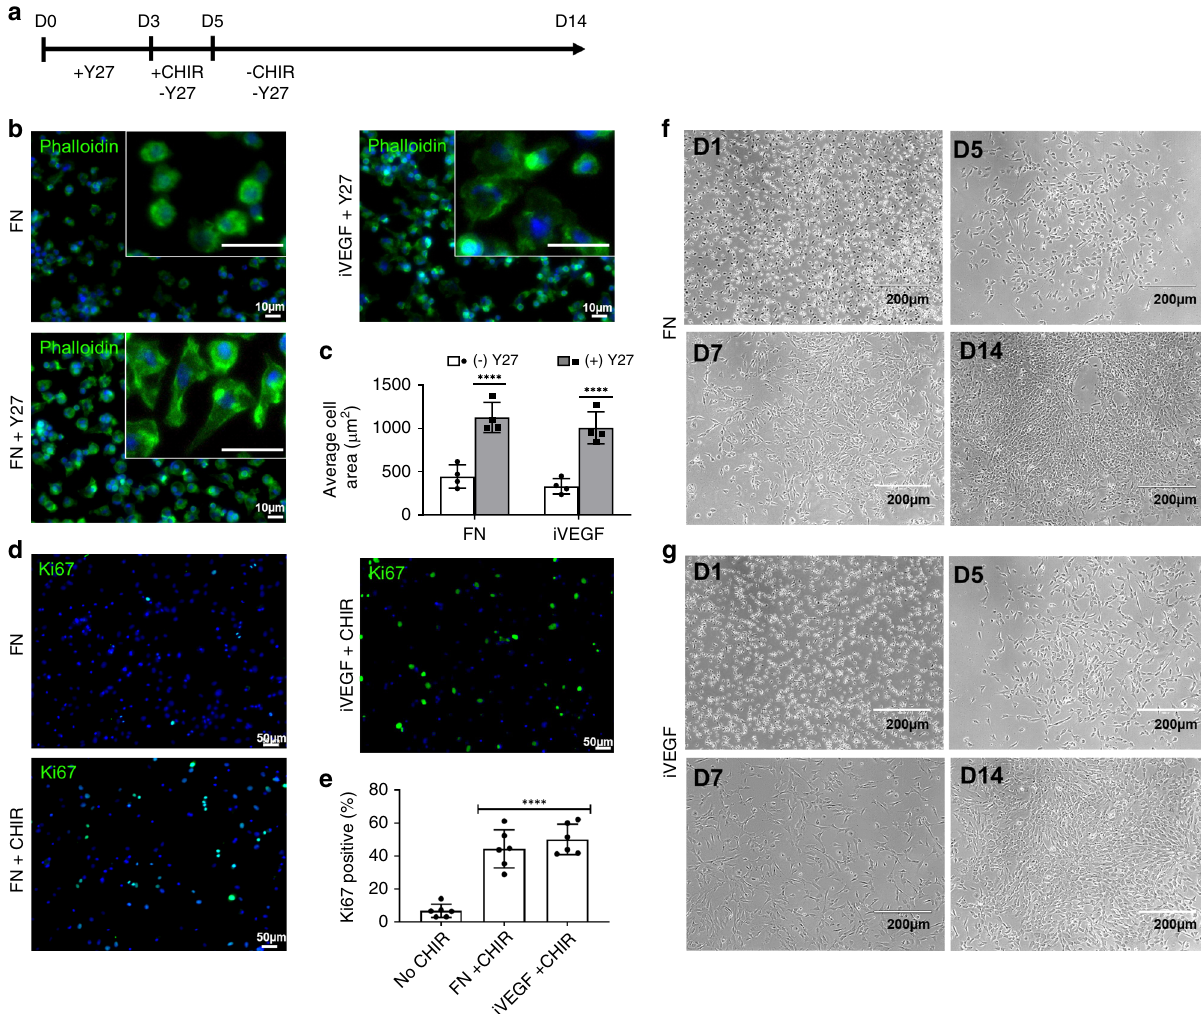
Fig. 4 Optimized Protocol for MC Differentiation. a Schematic of optimized protocol timeline. b Representative images of Y27 induced spreading of MC on both FN and iVEGFs and subsequent quanti fi cation of cell area ( µ m 2 ) ( c ) of phalloidin (green) stained cells. + Y27 (gray bars) and – Y27 (white bars); Signi fi cance denoted by (**** p < 0.0001) compared to surfaces without Y27 using two-way ANOVA with Sidak ’ s test (DF = 12, F = 81.82); n = 4 independent biological replicates; error bars denote ±SD of the mean. d Representative images of MC stained for the proliferation marker Ki67 (green) after CHIR treatment for 2 days and subsequent quanti fi cation of positive cells ( e ) four asterisk denotes statistical signi fi cance ( p < 0.0001) compared to No CHIR treatment using one-way ANOVA and Dunnett ’ s test (DF = 15, F = 42.32); n > 300 cells per n = 6 independent biological replicates; error bars denote ±SD of the mean. f , g Representative bright fi eld images of MC at the indicated times during the 14-day differentiation on FN ( f ) or iVEGF ( g